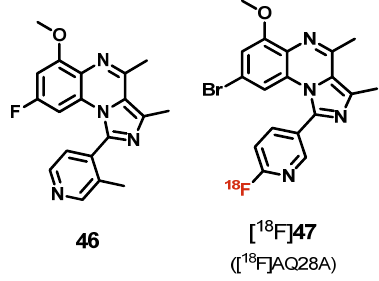
Figure 9. Molecular structures of a PDE10A inhibitor and the 18 F-labeled derivative thereof for